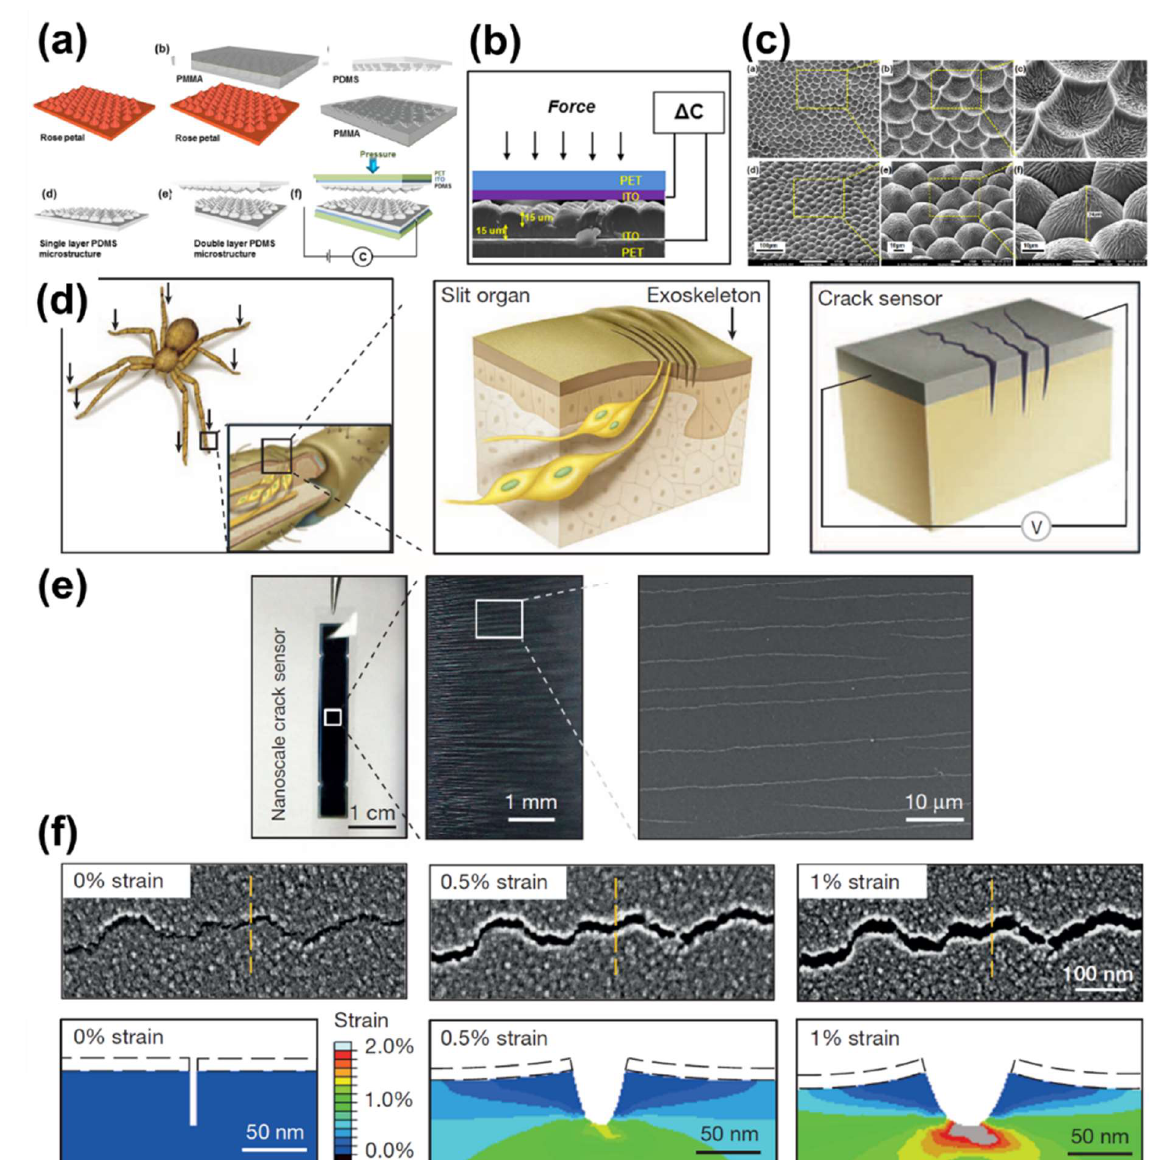
Figure 13. Schematic illustrations of biomimicking sensors. ( a ) Fabrication of rose petals biomimicking flexible PDMS micro/nano micro-dome structures. ( b ) Electrical measurement for a pressure sensor. ( c ) Surface morphology of rose petals [263]. © 2021 Elsevier Ltd. All rights reserved. ( d ) The spider has highly sensitive organs on its leg joints to detect external forces and vibrations. ( e ) Crack-based sensor and measurement scheme. ( f ) SEM images of zip-like crack junctions at applied strains of 0% (left), 0.5% (middle), and 1% (right). Finite-element method modelling of crack interface. White regions surrounded by black dashes represent 20-nm-thick Pt layers [264]. Copyright © 2021, Nature Publishing Group, a division of Macmillan Publishers Limited. All rights re- served.